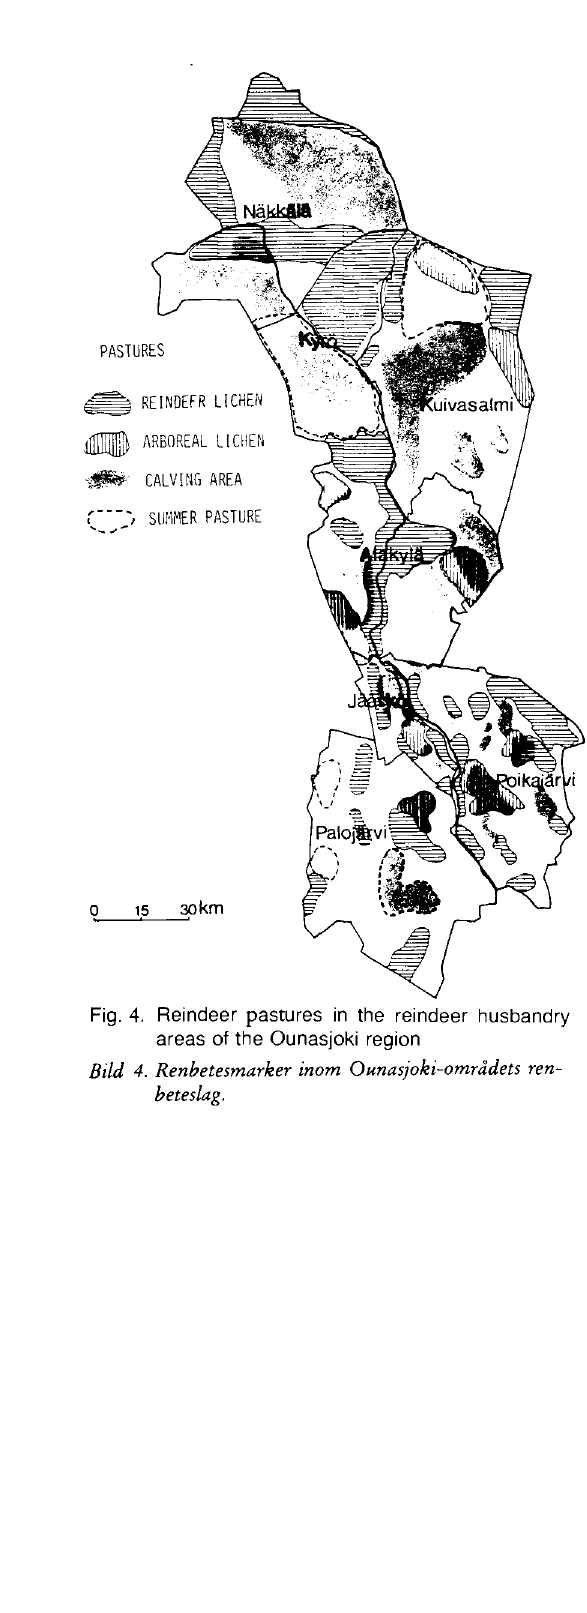
Fig. 4. Reindeer pastures in the reindeer husbandry areas of the Ounasjoki region Bild 4. Renbetesmarker inom Ounasjoki-omrddets ren-